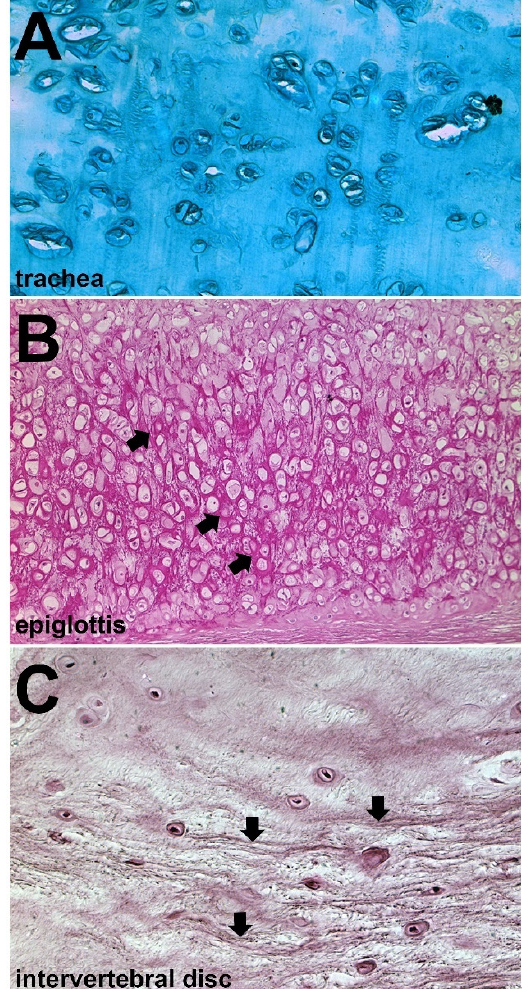
Figure 4. Common variants of cartilage in tetrapods. ( A ) Alcian stain of hyaline cartilage from human trachea. Chondrocytes are embedded in a deep extracellular matrix rich in acidic proteoglycans. ( B ) Orcein stain of elastic cartilage from human epiglottis. Chondrocytes are similar to hyaline, but elastic fibers are more prevalent. Arrows indicate elastic fibers. ( C ) H&E stain of fibrocartilage from human intervertebral disc. Chondrocytes are more interspersed, and collagenous fibers, indicated by arrows, run mostly parallel to one another. All three photographs depict tissue sections from the histological collection of the Department of Zoology, Comenius University in Bratislava.